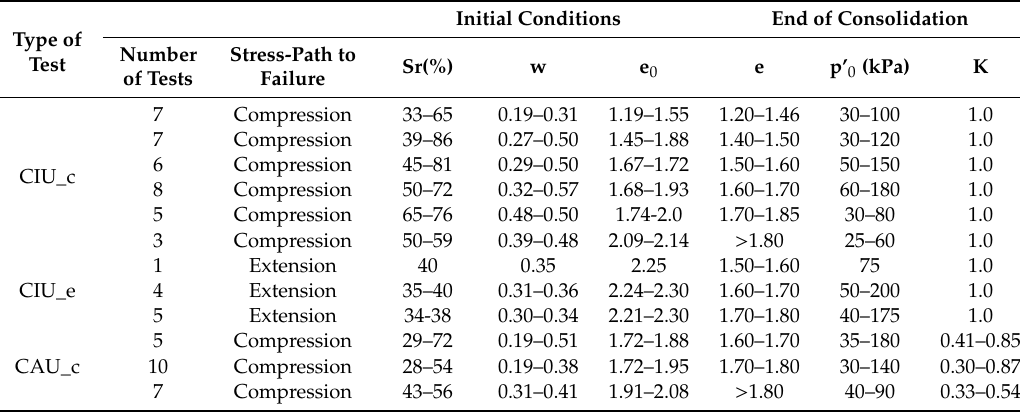
Table 1. Experimental